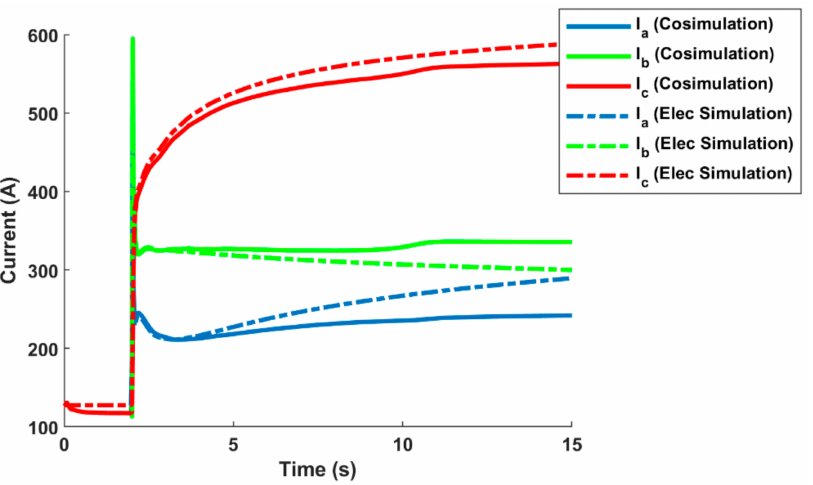
Figure 7. The input current of the first motor; when cosimulated, the motor is coupled to a common pump model connected to the NPPX loop.